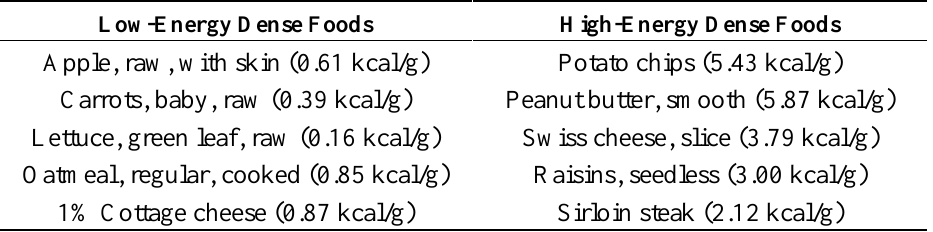
Table 4. Energy density (kcal/g) classification of commonly consumed foods. Low-Energy Dense Foods High-Energy Dense Foods Apple, raw, with skin (0.61 kcal/g) Potato chips (5.43 kcal/g) Peanut butter, smooth (5.87